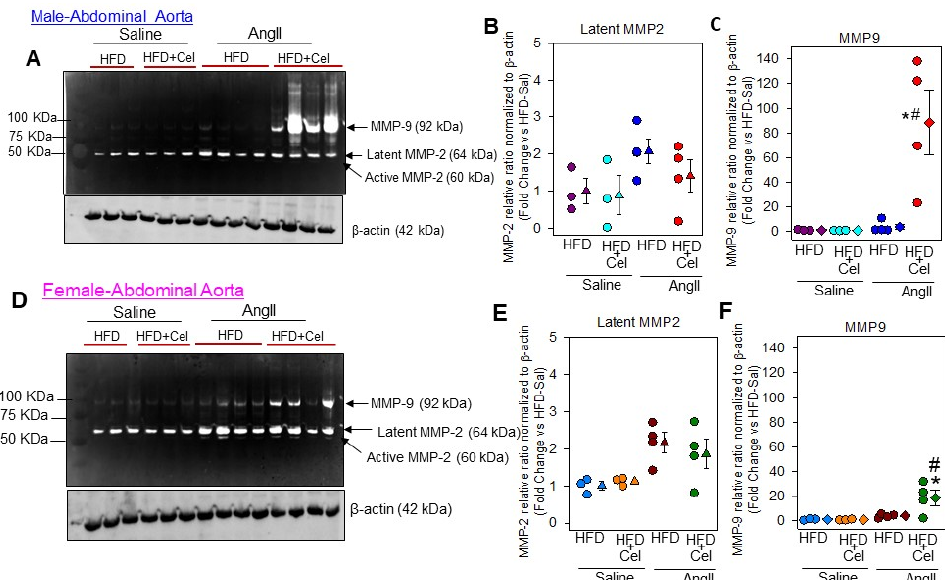
Figure 7. Gelatin zymography detected MMP-2, -9 in abdominal aortas from saline and AngII-infused male ( A ) and female ( D ) mice supplemented with a high-fat diet +/- Celastrol. Measurements of the relative ratio of MMPs in male ( B , C ) and female ( E , F ) normalized to loading control β -actin protein ( n = 4). Circles represent individual mice, diamonds represent means, and bars are SEMs. * Denotes p < 0.05 when comparing saline vs. AngII infusion; # p < 0.05 AngII + HFD vs. AngII + HFD + Cel (two ‐ way ANOVA with Holm–Sidak post hoc analysis). AngII: angiotensin II, HFD: high ‐ fat diet, Cel: Celastrol.